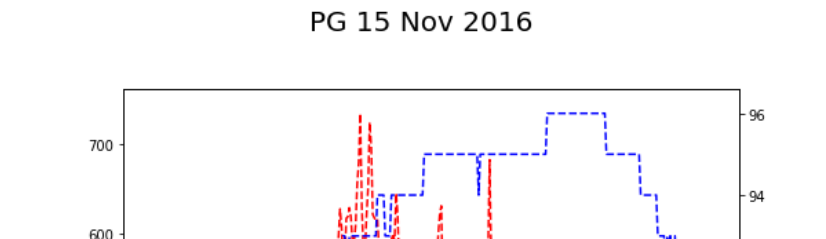
Figure 2. The 15 November 2016 fog case study. Hourly values of humidity ( top left ), wind speed ( top right ), full day PG ( bottom left ), and the hourly values of the PG between 5:00–11:00 local time ( bottom right ). The vertical black line marks the timing of sunrise at 6:07 LT.